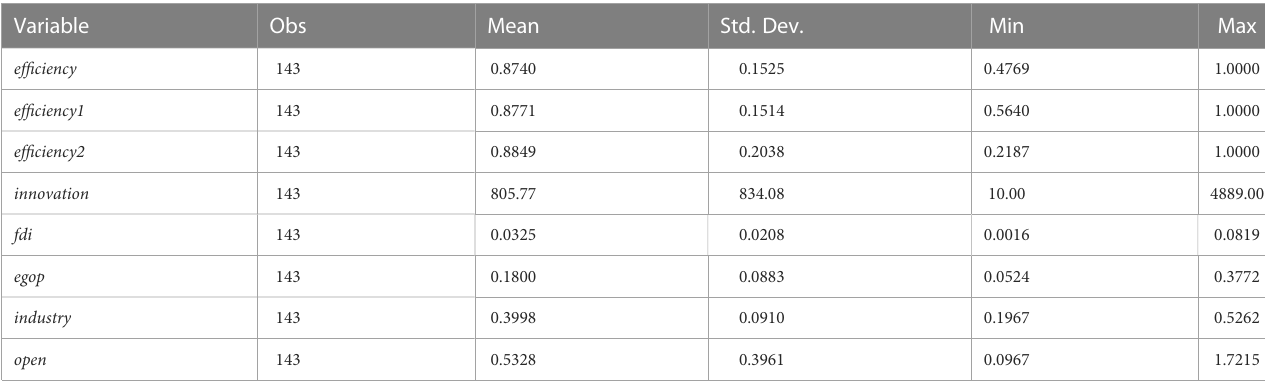
TABLE 2 Descriptive statistics of the regression